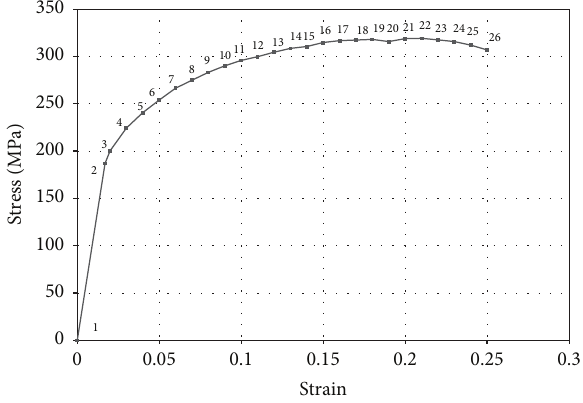
Figure 13: Stress strain curve plotted in MSC-MARC for condition 1.